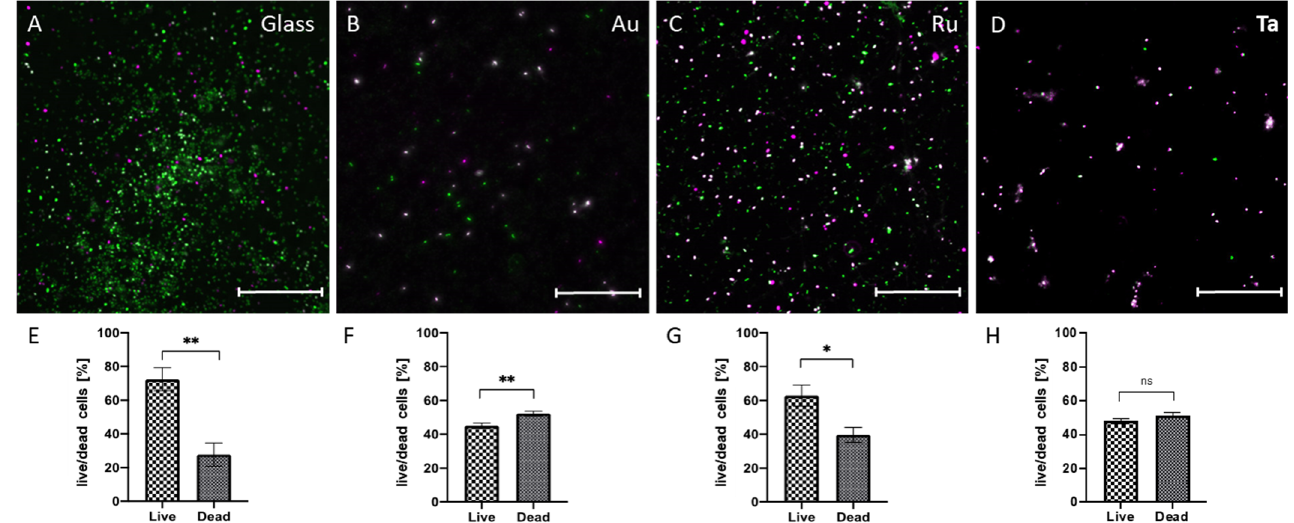
Figure 5. LIVE/DEAD Assay of Pseudomonas aeruginosa analyzed by CLSM. After cultivation of P. aeruginosa for 24 h on different surfaces bacteria were stained with Syto 9 representing live cells in green and dead cells in purple (propidium iodide) ( A – D ). Scale Bars = 20 μ m. Evaluation of live and dead bacteria in percent ( E – H ). Note the high amounts of living bacteria on glass ( A , E ) in contrast to the highest amount of dead bacteria on gold ( B , F ). Definition of statistical significance: p < 0.05 (*), p < 0.01 (**), p < 0.001 (***), p < 0.0001 (****).